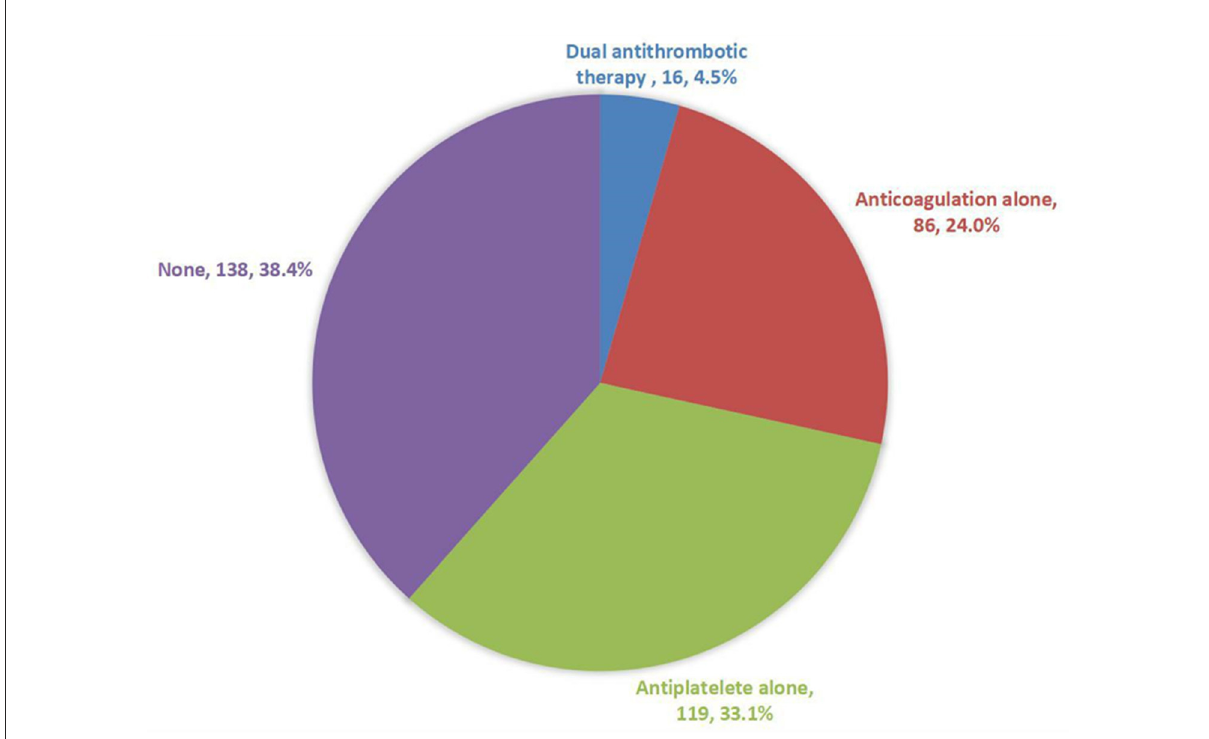
FIGURE3 Current status of antithrombotic treatment in patients with atrial fibrillation who were alive at the end of the